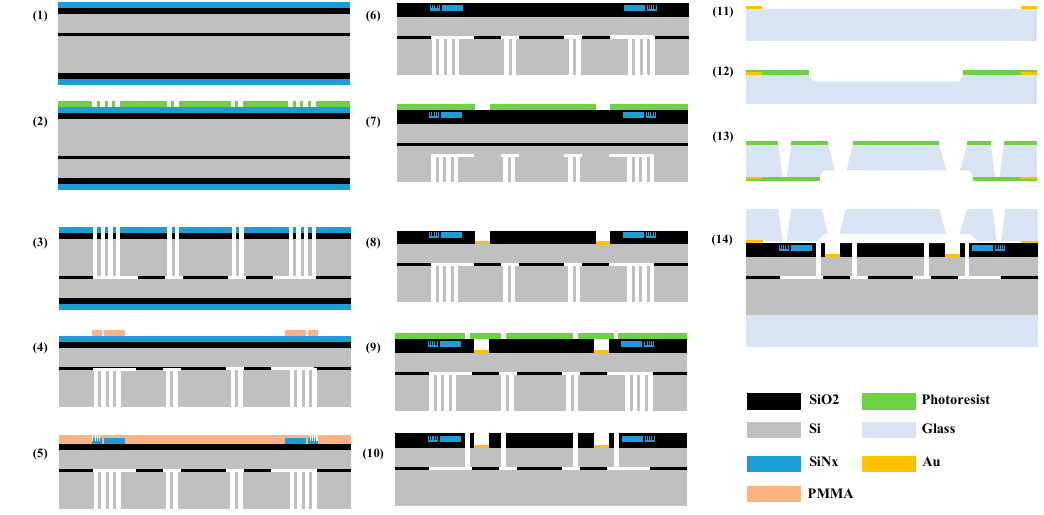
Figure 16. The fabrication process of the MOEMS gyroscope.